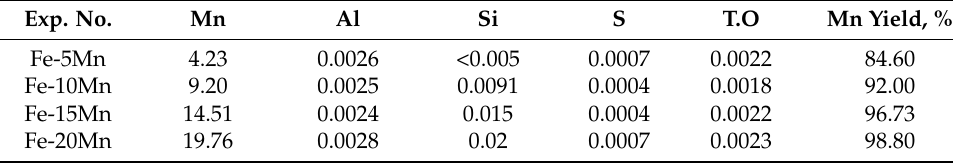
Table 3. Chemical composition of steel samples after equilibrium, mass%. Exp. No.